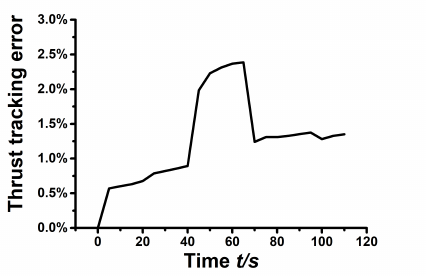
Figure 8. Thrust tracking